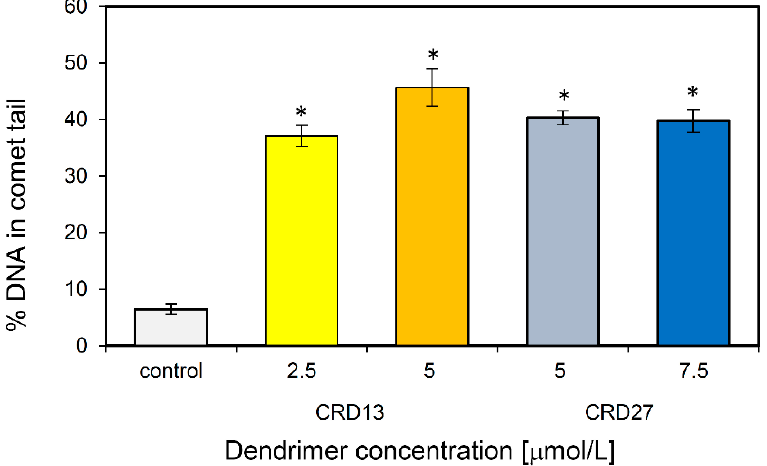
Figure 4. DNA (%) in the comet tail of the control cells and of 1301 cells treated with di ff erent concentrations of CRD13 and CRD27 dendrimers. Fifty cells were analyzed in each treatment. The values are the mean ± SD of three independent experiments. *Statistically significant di ff erences from the control cells (* p < 0.05).